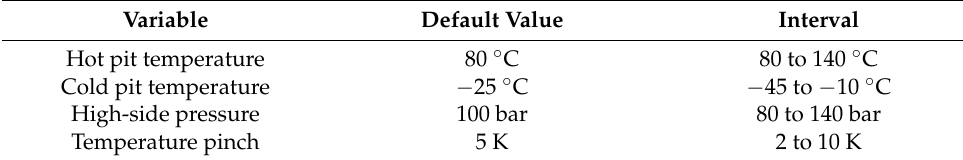
Figure 7. Evolutions of COP depending on temperature pinch. Table 2. Variables of the parametric